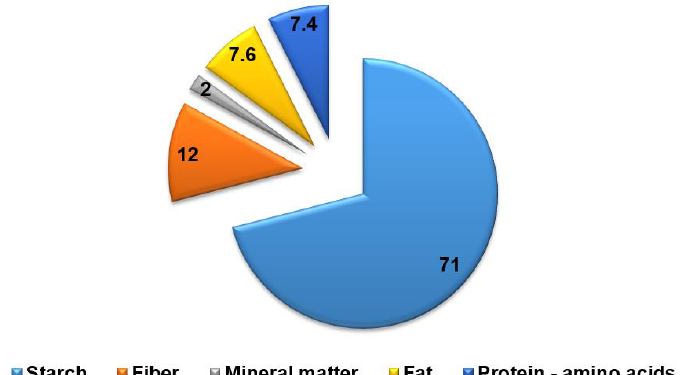
Figure 3. Chemical composition of maize grain (authors’ own elaboration). Table 1. Content of individual elements in the molecules of the maize grain sampled in each quarter, determined by elemental analysis.